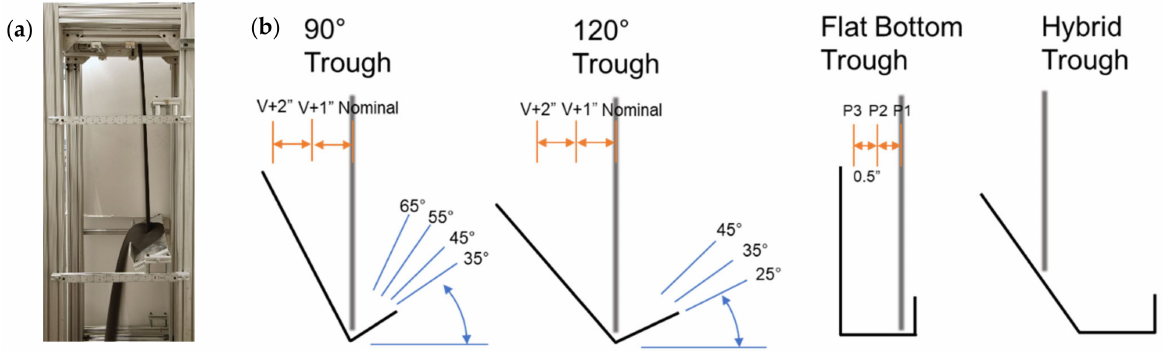
Figure 5. An example trough in the StAIR design ( a ), and various trough geometries that are experimentally tested in a cold-flow test rig ( b )